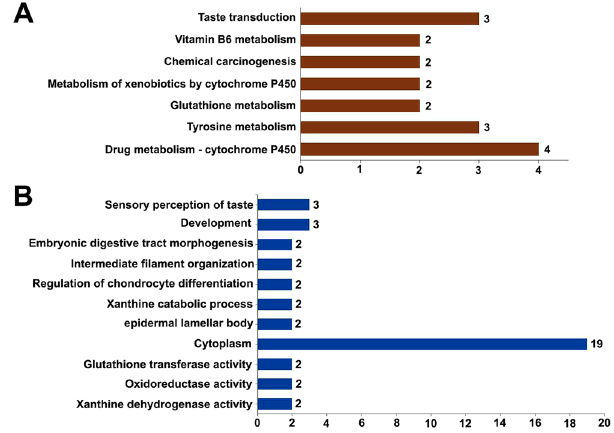
Figure 7. Histogram presentation of the number of shared DEGs belonging to significant pathways ( A ) and selected gene ontology (GO) terms ( B ). The shared DEGs were detected by comparisons of both GE vs NGE and GE vs GM of the base of oral